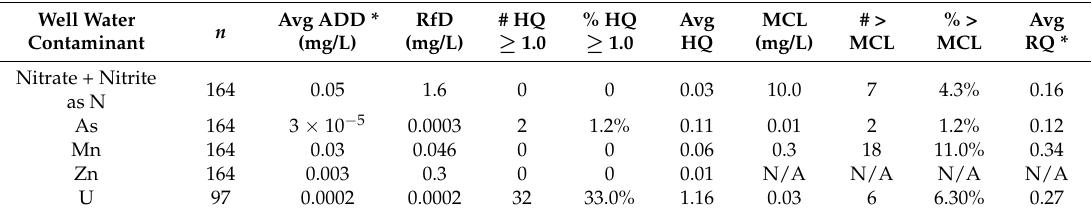
Table 7. Average contaminant concentrations, average daily doses (ADDs), hazard quotients (HQs) exceeding 1.0, MCLs, MCL exceedances and average risk quotients (RQs) for each of five principal inorganic contaminants in home well water on the Crow